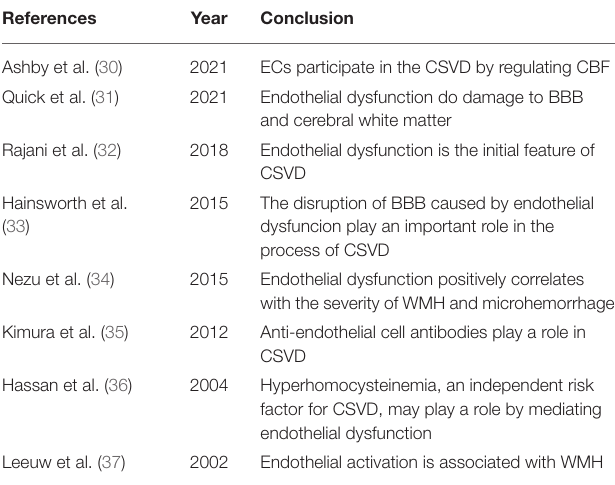
TABLE 2 | Studies suggest that the injury to endothelial cells (ECs) is involved in the pathology of